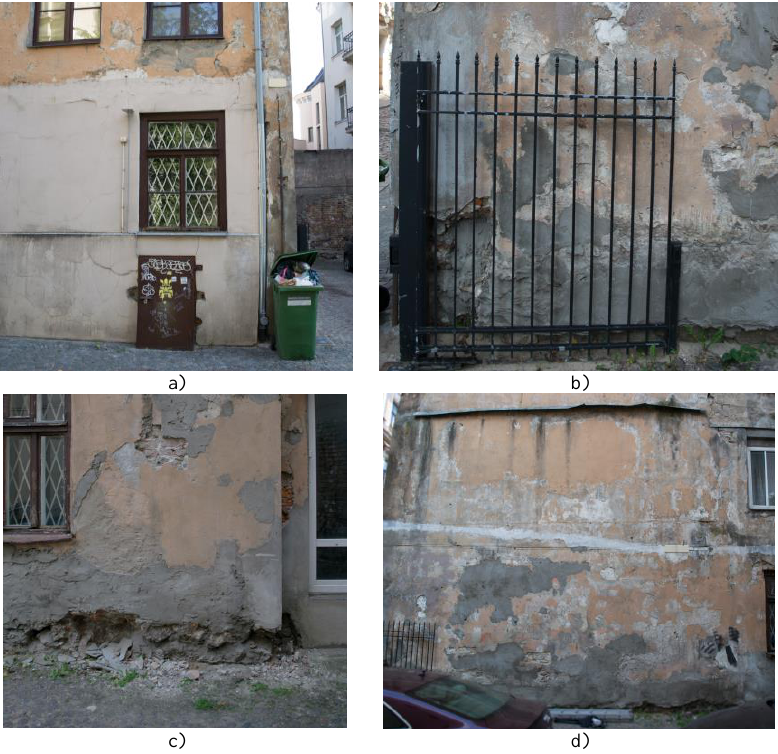
Fig. 3. Façade of the building: a) South-West façade; b) South corner; c) right corner of South-East façade; d) South-East